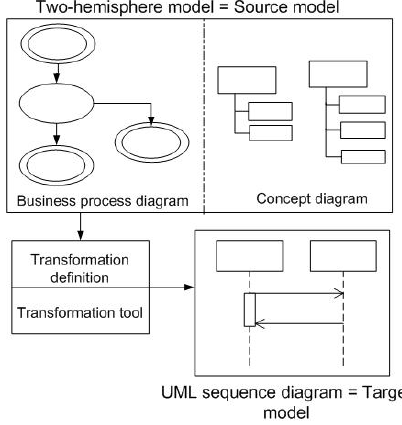
Fig. 1. The idea of transformation from the two-hemisphere model to the UML sequence diagram A. Target model: the UML sequence